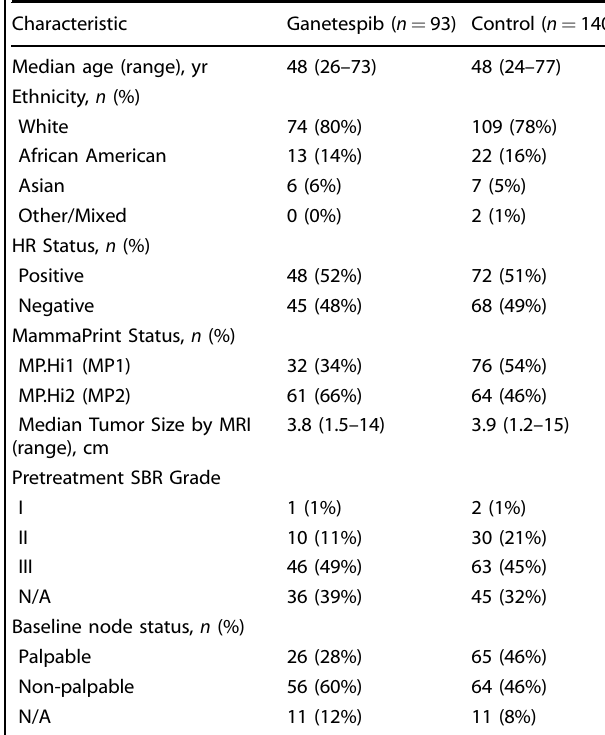
Table 1. Baseline patient